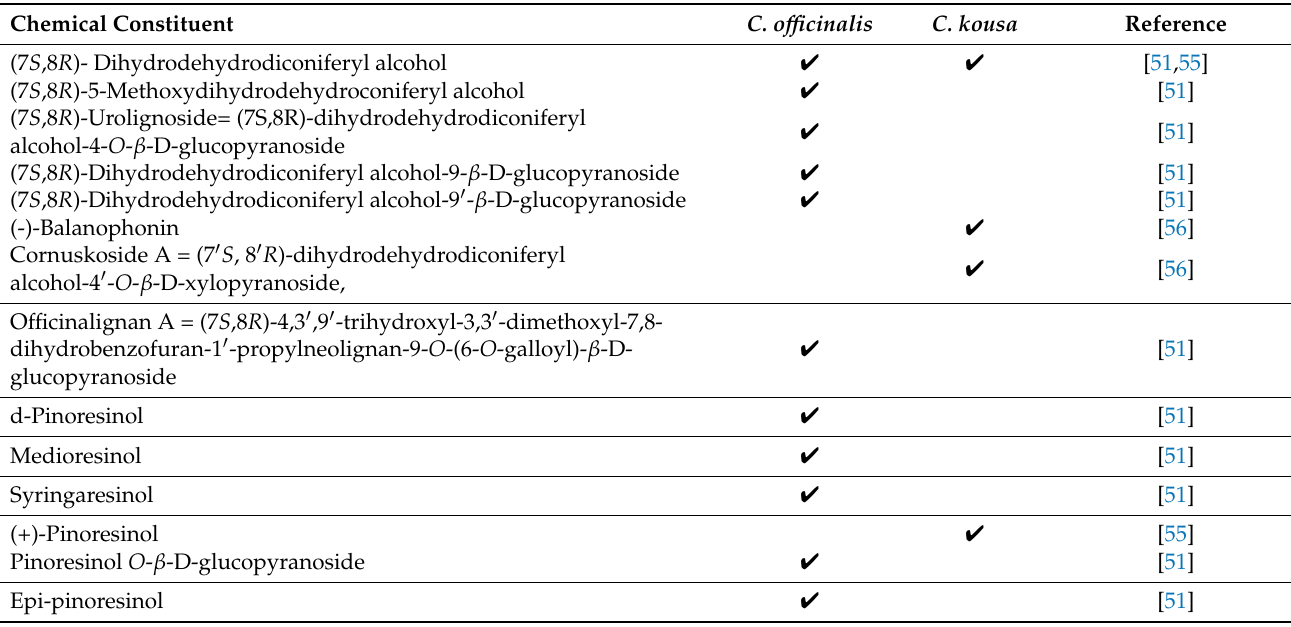
Table 4. The main lignans of Cornus